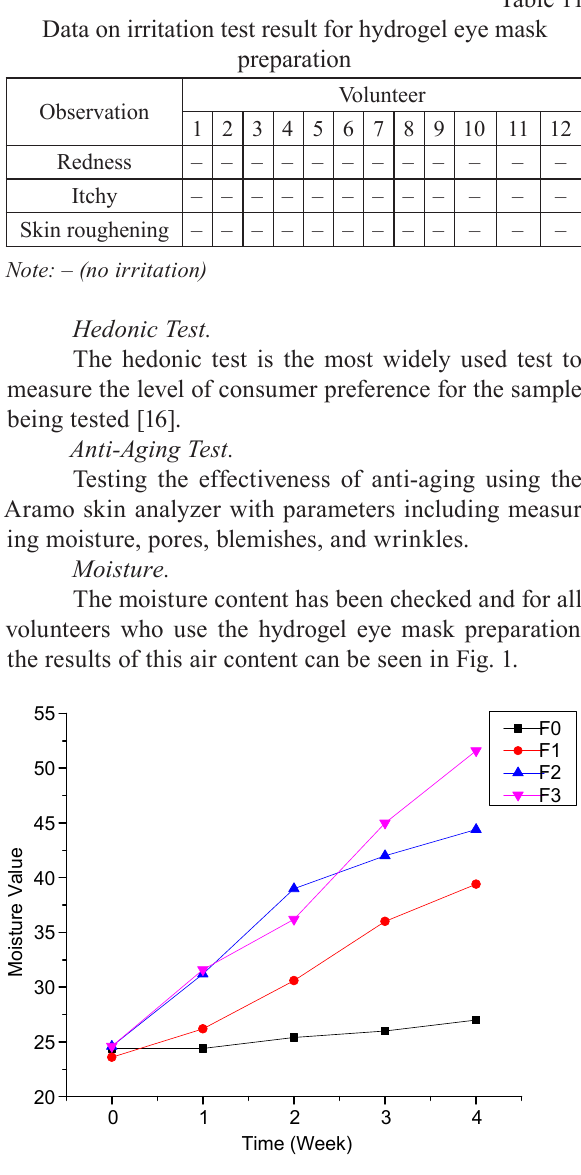
Fig. 1. Graph of the effect of the yellow potato hydrogel eye mask preparation on moisture values